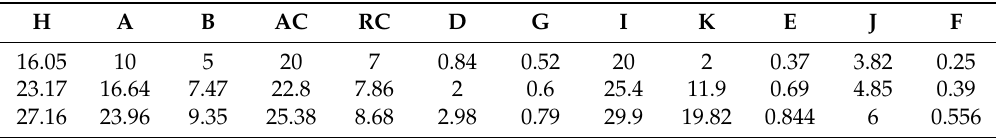
Table 4. Raw material value selection (in percentage/100 g).